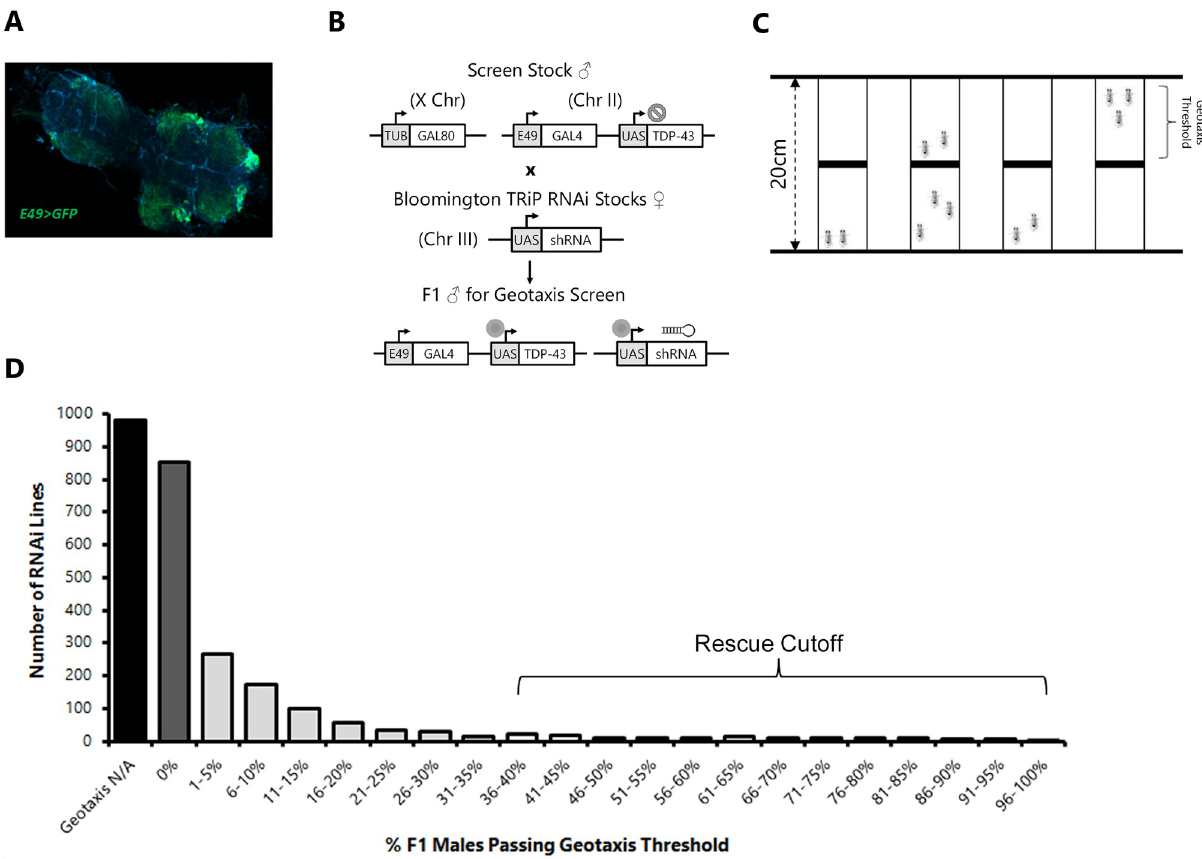
Fig 1. shRNA screen for suppressors of motor-neuron driven TDP-43 negative geotaxis defects. (a) Confocal microscopy image (10x objective) of dissected thoracic ganglion showing GFP expression driven by E49-Gal4. (b) Diagram of cross scheme used in screen. Males from parental strain carrying an X-linked Gal80 and autosomal E49 motor GAL4 driver (subset of motor and sensory neurons) and a codon-optimized human TDP-43 transgene on chromosome II were crossed to virgin females from candidate shRNA lines yielding F1 males lacking GAL80 and therefore expressing TDP-43 and the candidate shRNA in E49 neurons. (c) Diagram of negative geotaxis setup for behavioral rescue assay. (d) Histogram showing shRNA lines (y-axis) binned by geotaxis performance (% of flies crossing 10cm threshold in 10 seconds, x-axis) across all tested shRNA lines. Black bar indicates crosses for which geotaxis was not possible due to low number of eclosing males. Dark gray bar indicates lines for which sufficient flies were obtained, but none of them were capable of climbing to the threshold within 10 seconds. Light gray bars are histogram bins in which at least 1 fly was able to cross threshold within 10 seconds. The horizontal bracket indicates the cutoff for retesting as a candidate suppressor.